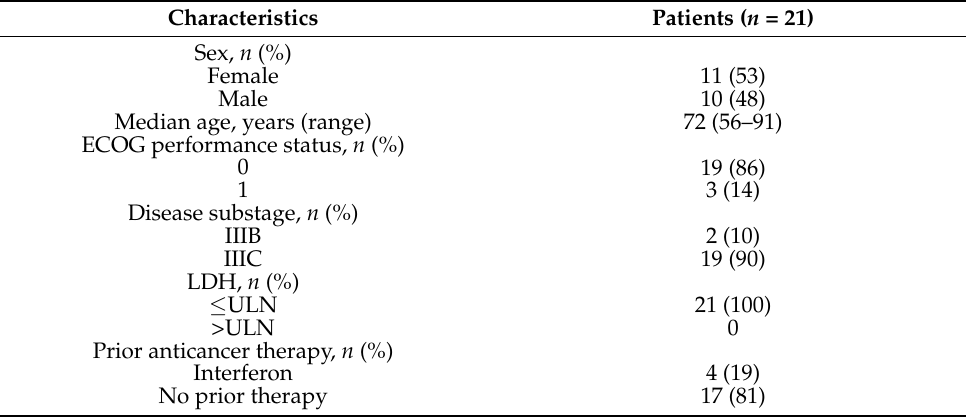
Table 1. Patient demographics and clinical characteristics at